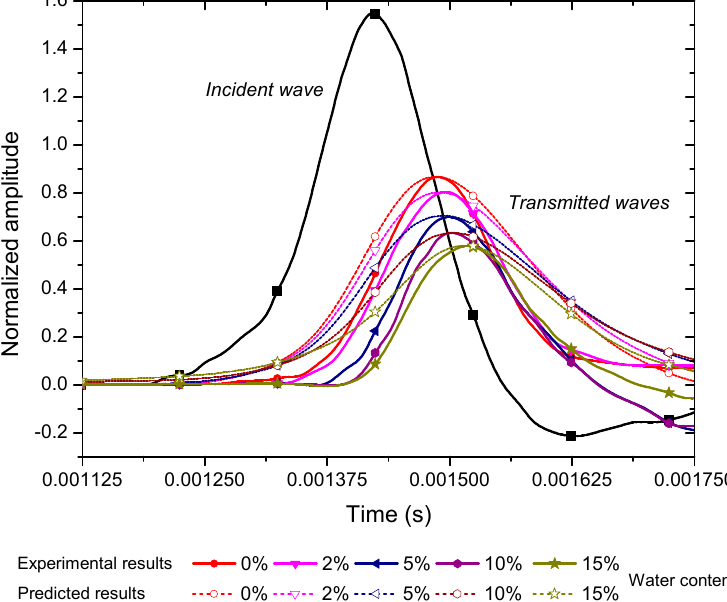
Figure 2. Variation of waveforms with the water content by experiments (reproduced with permission from [12], Springer Wien, 2015) and predicted results by our analytical model.